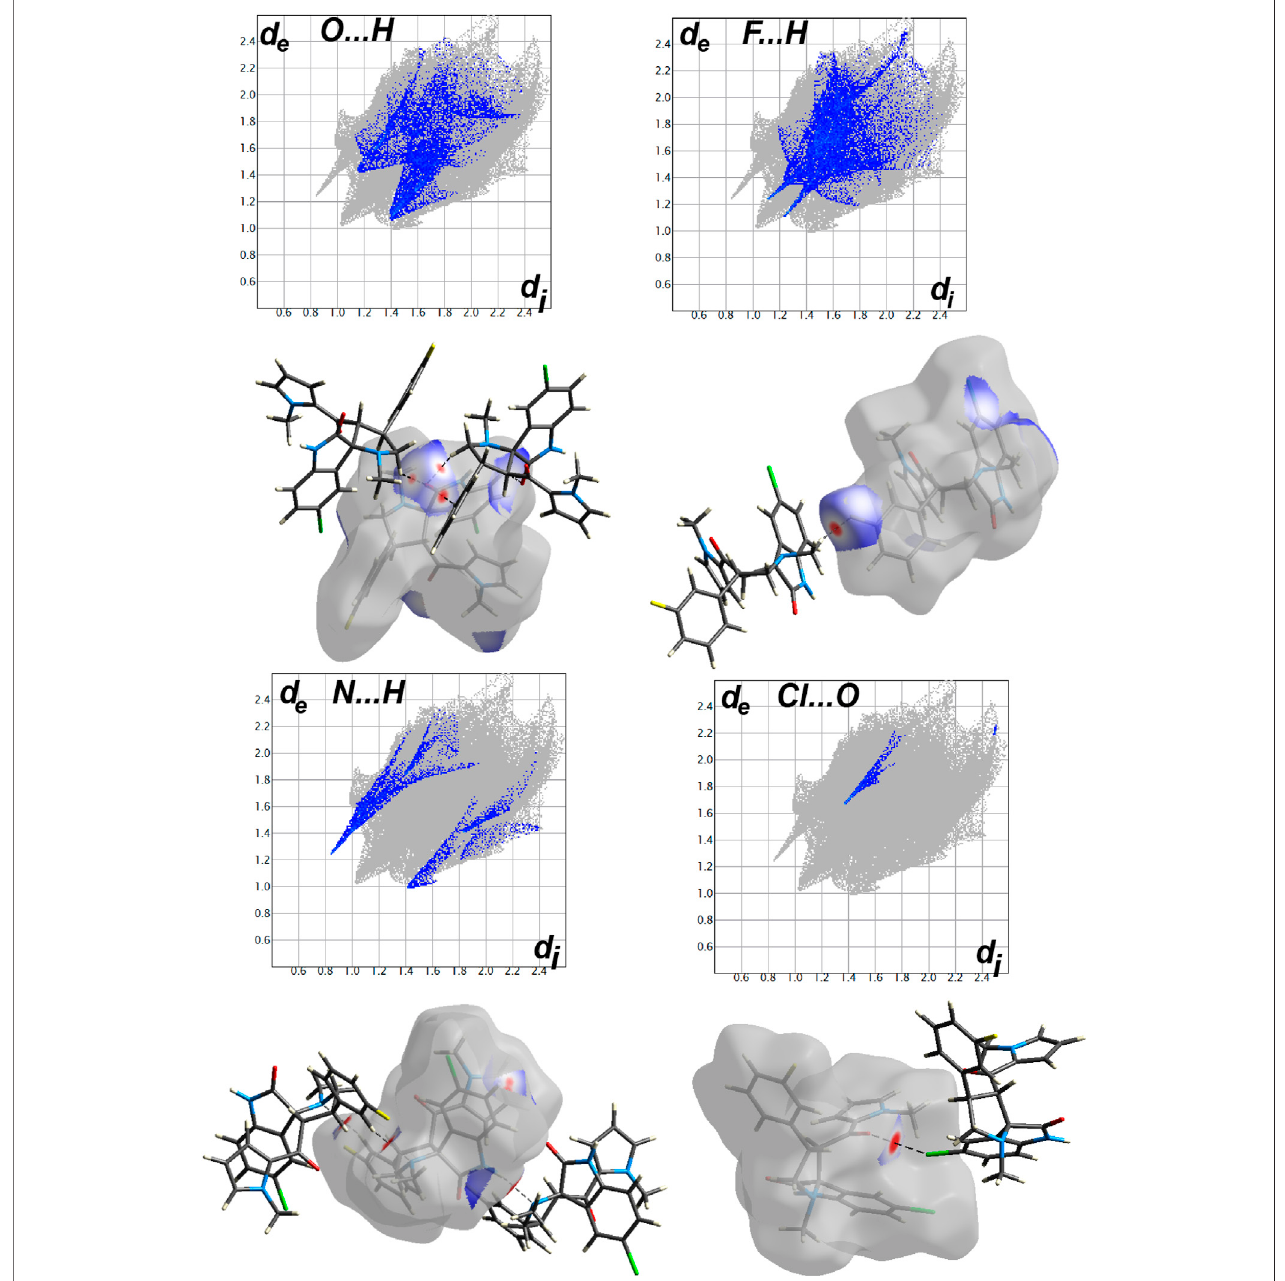
FIGURE 7 | Hirshfeld analysis of 2a